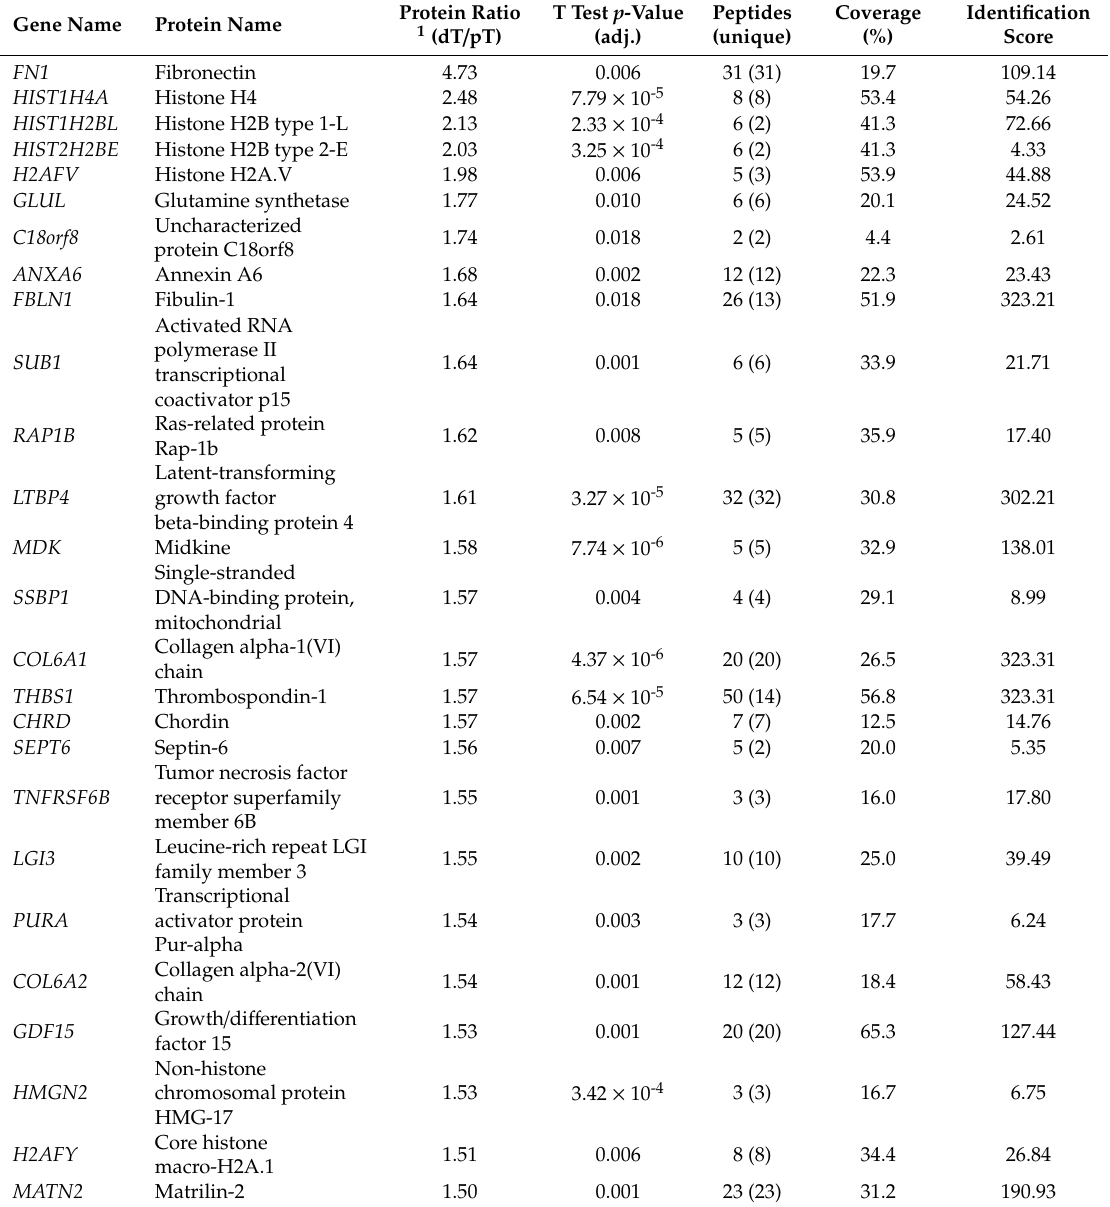
Table 1. 26 Significantly upregulated proteins in